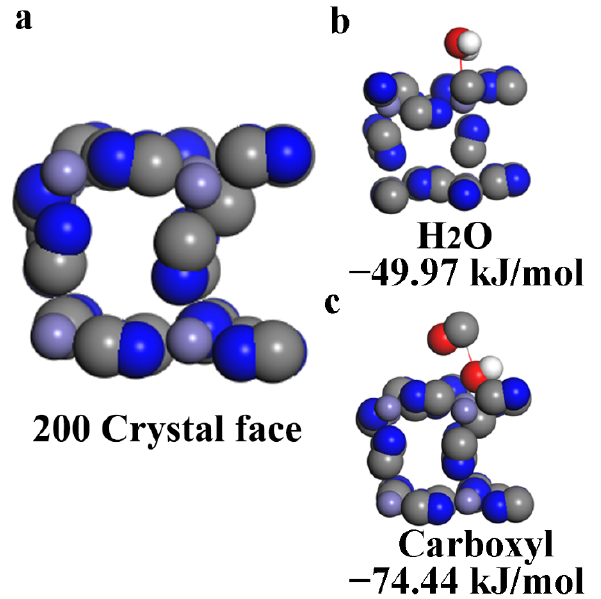
Figure 4. The size of the vacuum space was set to be 15 Å to prevent the interaction of atoms. The generalized gradient approximation (GGA) function with a Perdew–Burke– Ernzerh method (PBE) was utilized as the exchange-correlation functional [37]. The double numerical plus polarization (DNP) function was set as the basis set. The effective core potentials (ECP) were used in the calculations. The following convergence criterion were met: 10–5 Ha for total energy, 0.002 Ha/Å for force, and 0.005 Å for displacement. The adsorption energies ( ∆ E) of molecules on PB (200) were calculated using the following equation: ∆ E = Emolecule/PB (200)—Emolecule—EPB (200), where Emolecule/PB (200), Emolecule and EPB (200) are the total energies of the adsorbed molecule on PB (200), the free molecule and bare surface from DFT calculations, respectively. According to this PB (200). This proves that the binding energy between Prussian blue and the carboxyl functional group was stronger than that between water and Prussian blue. Therefore, Figure 3. ( a ) Electrochemical cycle performance at 1 C, 1 C = 170 mA g − 1 . ( b ) Efficiency of each elec- trochemical cycle at 1 C, 1 C = 170 mA g − 1 . ( c ) Electrochemical rate performance from 0.2 C to 20 C, the modification of the carboxyl group on the surface of Prussian blue would inhibit the formation of interstitial water in the structure.